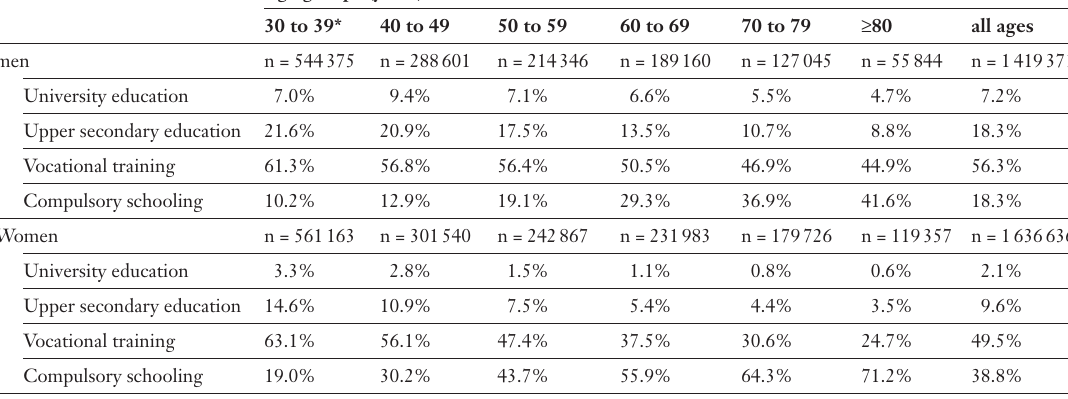
Table 1 Distribution of popu- lation across age groups and educa- tional classes, Swiss nationals living in German speaking Switzerland,